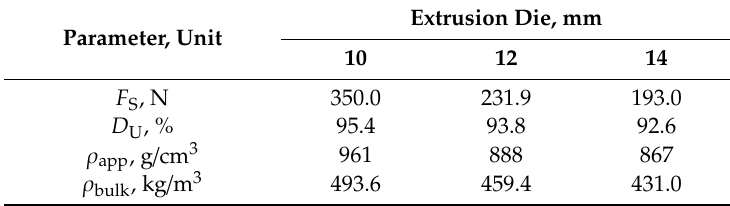
Table 3. Properties of briquettes produced (variable: extrusion process pressure).